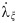
Block diagram of the feedback-loop in model-falcons.This diagram is intended to communicate the general structure of the model. A detailed explanation of the model equations is provided in Materials and methods. The boxes denote transfer functions, and additional parameters of the functions are noted in between brackets. Most of the feedback loop is generic, except for the detailed implementation of flapping flight contained in the black box labelled “dynamics and control”. A brief summary of the feedback loop now follows, in which we walk through each of the different segments of the feedback loop summarised as “Vision”, “Guidance”, “Dynamics and Control”, “Kinematics”, and “Vector Geometry”. Vision: to determine how it should turn, the falcon first extracts the line-of-sight angle λ, which is measured subject to visual error ξ. The measured line-of-sight angle λξ is subsequently transformed into an angular velocity vector λ˙ξ that denotes the estimated rate of change in the line-of-sight. The resulting signal from the visual system is fed to the guidance function every time interval τ, as denoted by the block labelled “sample … and hold”. Note that we also test an alternative implementation of visual processing delay in the model (continuous and delayed, instead of in discrete update intervals), as little is known about the nature of delay in birds. Results using either form of delay are highly similar (see S1 Fig). Guidance: the falcon’s guidance system multiplies the estimated line-of-sight rate λ˙ξ by the navigation constant N to obtain the commanded change in the angle of the falcon’s velocity γ˙ (see Eq 1), and the cross product is taken with the velocity of the falcon to obtain the commanded acceleration α^. The dynamics and control function depends on the morphological parameters μ1, … μn and manipulates the wing shape and motion to produce an acceleration α which maximizes the forward acceleration whilst meeting the commanded acceleration as closely as possible (see Materials and methods section D.2 and E for detailed model equations). Kinematics and Vector Geometry: the acceleration of the falcon α is integrated in the kinematics section and fed back to the visual system through the medium of the vector geometry needed to relate the line-of-sight angle to the updated positions of the model-falcon and model-starling. Note that the segment of the block diagram labeled “Vector Geometry” operates outside of the model-falcon, so we do not imply that the falcon cognitively represents either its own position or that of its target. In particular, the falcon has no knowledge of—and no need to know—the distance to its target; all that the falcon needs to know is the direction of its target as measured visually by the line-of-sight angle, and its own velocity, which is needed to determine the commanded acceleration from the commanded turn rate. Model-starlings have a similar control-loop, in which the segments of the feedback loop labelled “Vision” and “Guidance” are replaced by a forcing function ζ(t) that determines their (desired) trajectory (see Materials and methods section C).